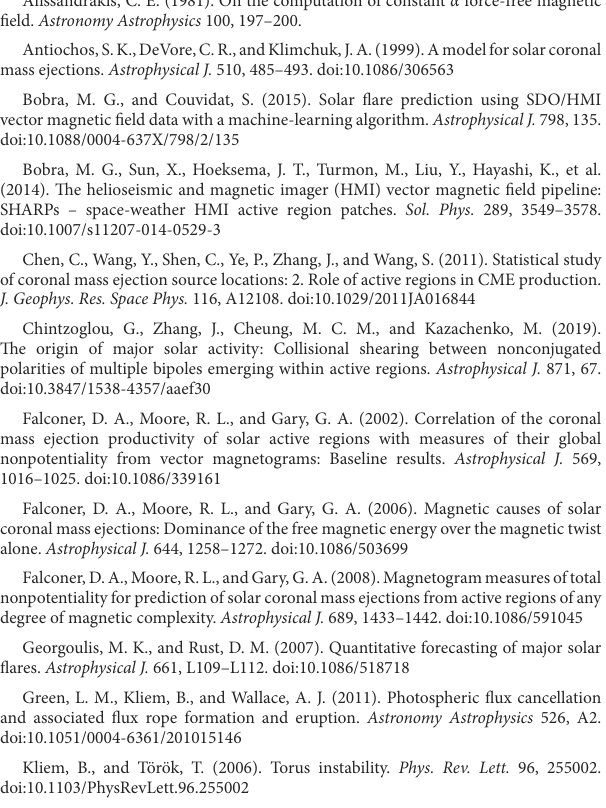
SUPPLEMENTARY VIDEO S3 Online movie 3, generated from a sequence of images similar as in Figure 6 . SUPPLEMENTARY VIDEO S4 Online movie 4, generated from a sequence of images similar as in Figure 7